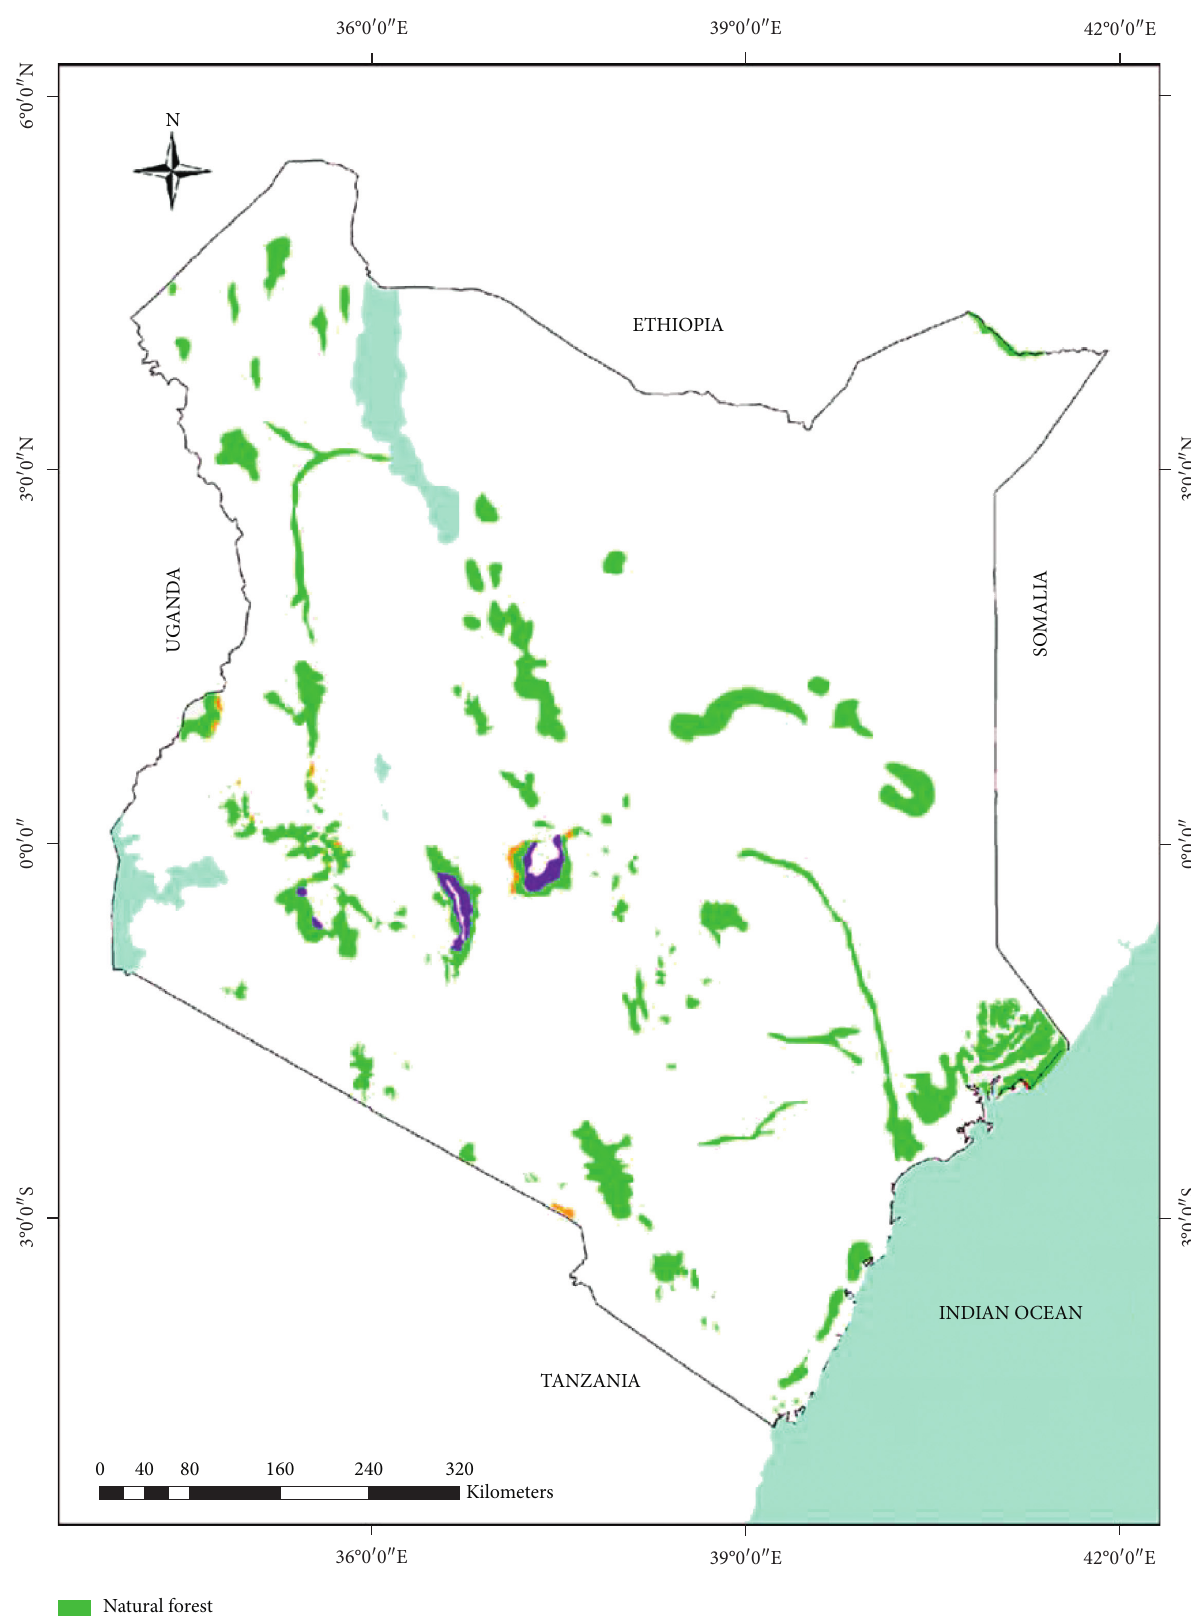
Figure 1: Map of Kenya showing the distribution of natural forests. Source: National Forest Program Secretariat